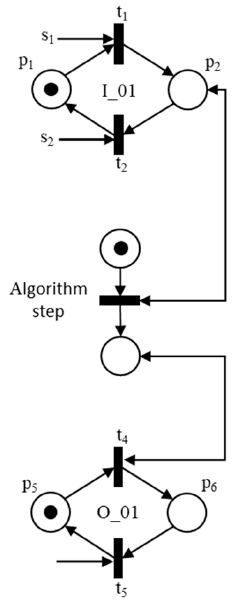
Figure 6. Model for the second process.